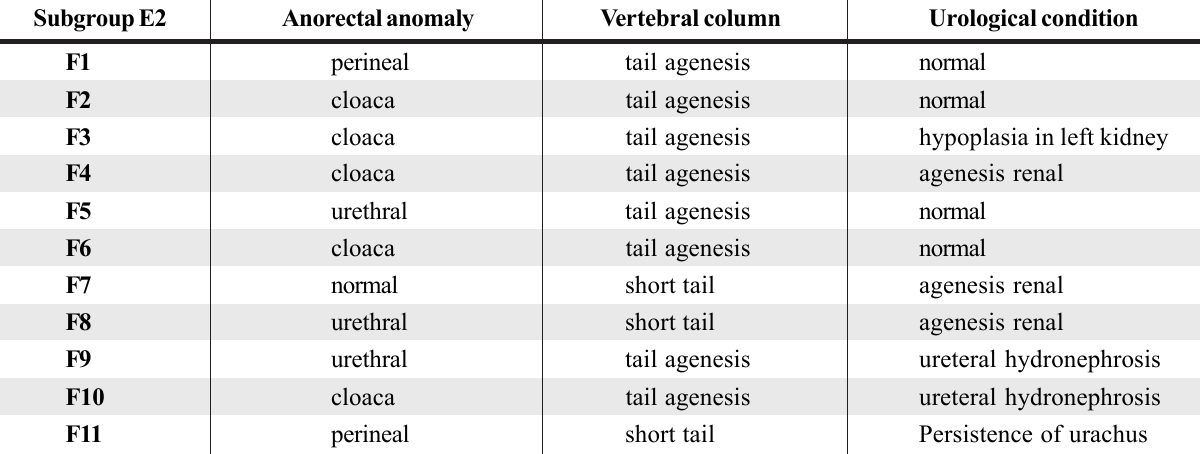
TABLE 6 - Associations between anomalies for the fetuses in subgroup E2